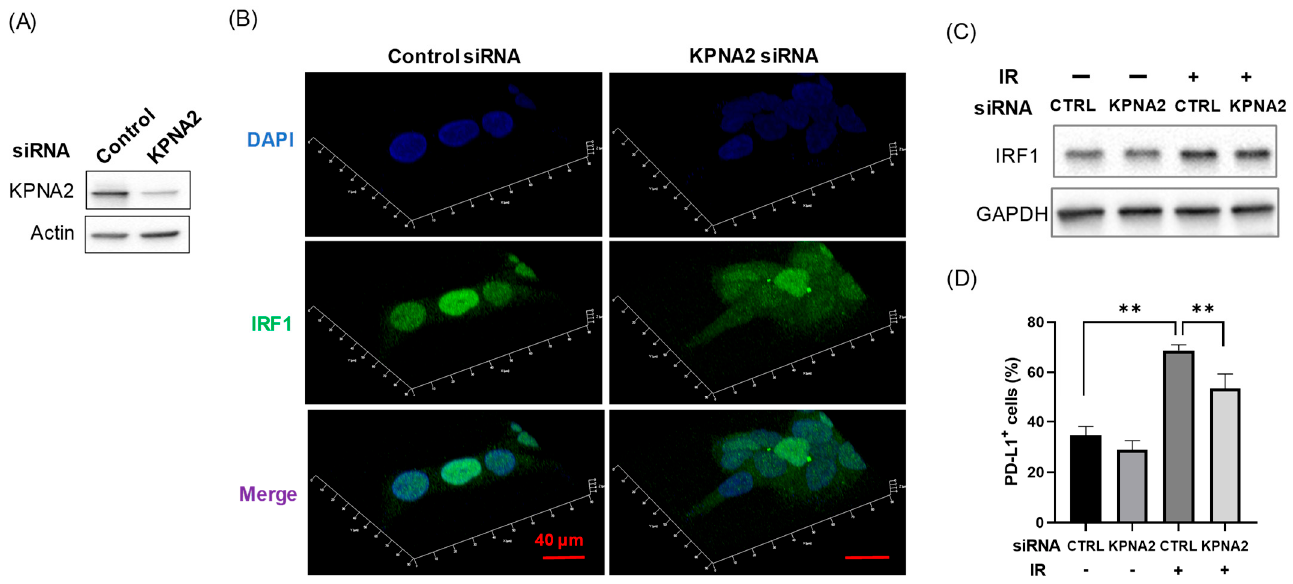
Figure 5. Effects of KPNA2 knockdown on radiation-increased IRF1 and PD-L1 expression in Ca9-22 cells. ( A , B ) Ca9-22 cells transfected with control or IRF1 siRNA were harvested for western blot analysis of confocal images of IRF1. ( A ) An image of a representative immunoblot is shown. Actin was used as a loading control. ( B ) Confocal images of IRF1 in Ca9-22 cells are shown. The images are 3D constructions with maximum intensity. Scale bar, 40 µ m. ( C ) IRF1-knockdown Ca9-22 cells were irradiated with 6 Gy and cultured for 24 h. Afterward, the cells were harvested for western blot analysis of IRF1 expression. An image of a representative immunoblot is shown. GAPDH was used as a loading control. ( D ) IRF1-knockdown Ca9-22 cells were irradiated with 6 Gy and cultured for 4 days. Afterward, the cells were harvested for analysis of cell surface PD-L1 expression. ** p < 0.01. CTRL,